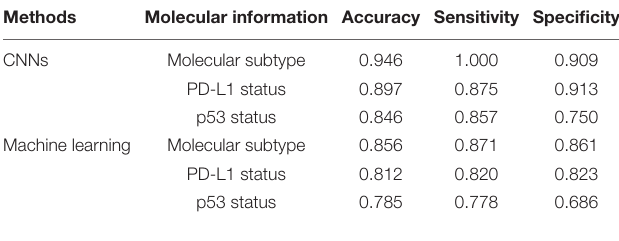
TABLE 4 | The performance of molecular information recognition with convolutional neural networks (CNNs) or machine learning.